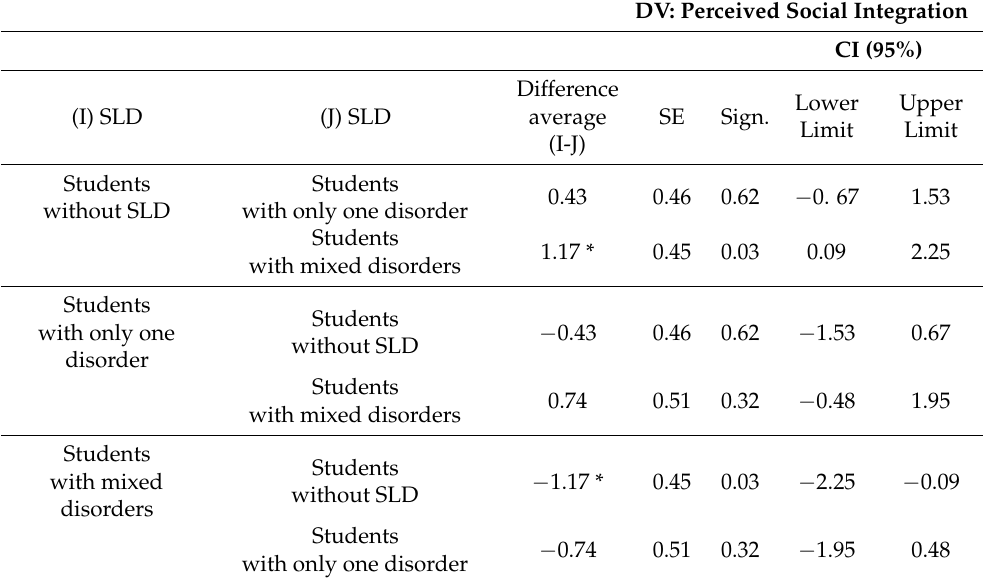
Table 3. Result of Tukey’s post-hoc test for perceived social integration between groups (students without SLD, students with only one disorder, students with mixed